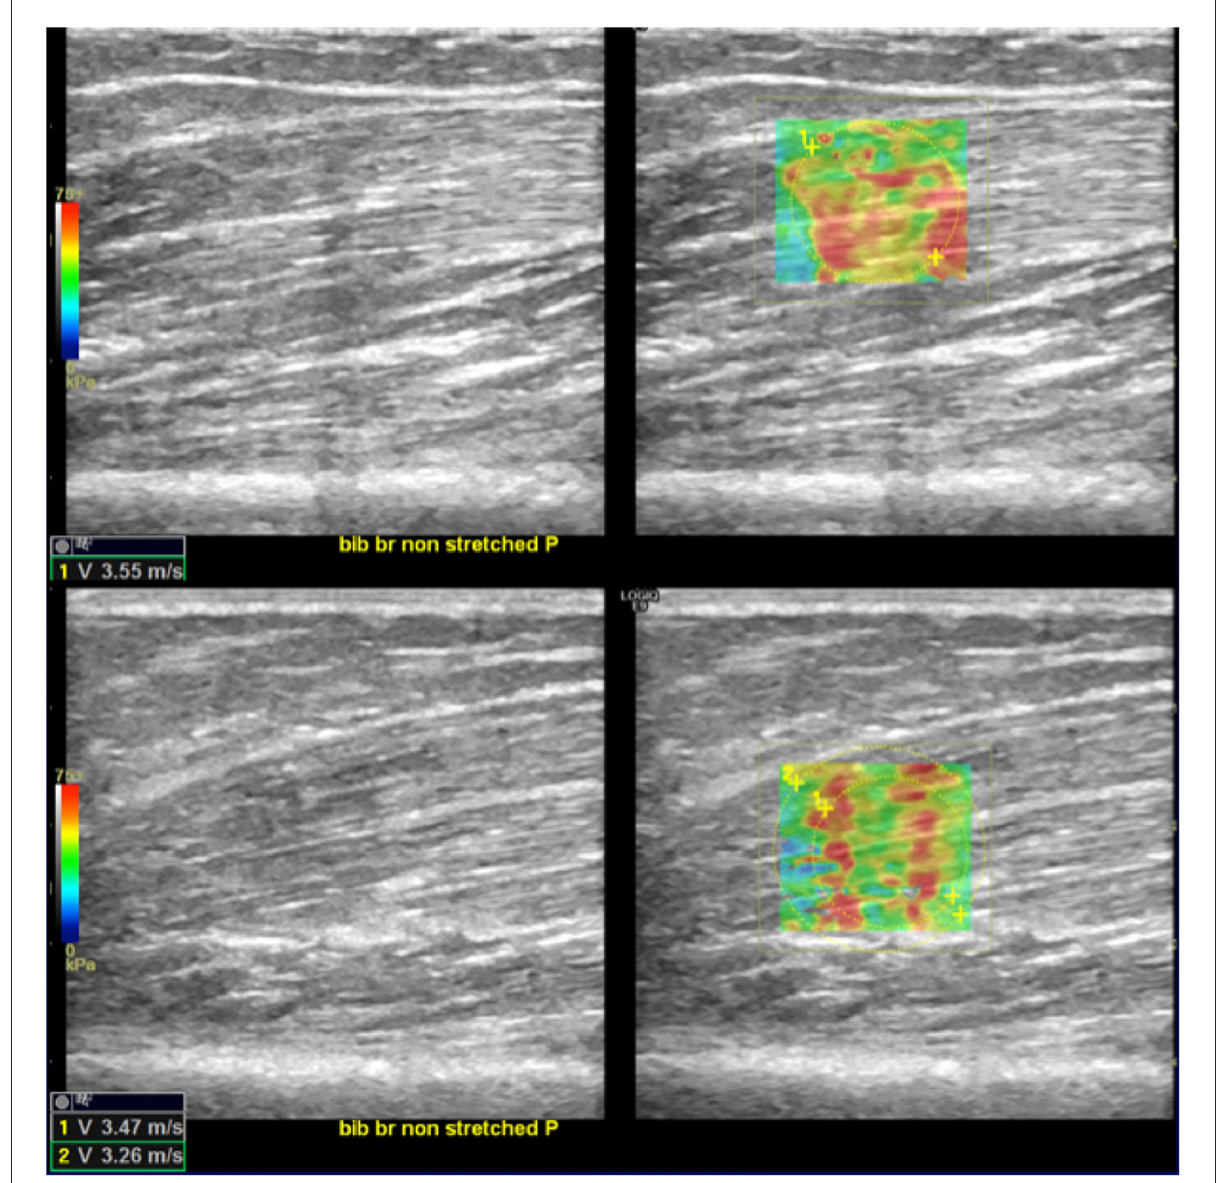
FIGURE5 SWE reduction between T0 and T1. In the upper-right quadrant is illustrated an example of an elastogram (superimposed to the B-mode image) generated by an ROI placed in the biceps brachii muscular belly along the direction of the fibers at T0; in the lower right image, the same evaluation at T1 shows lower values (lower left corners of the images). Images on the upper- and lower-left quadrant are the respective B-mode conventional US image automatically paired on the screen by the SEL